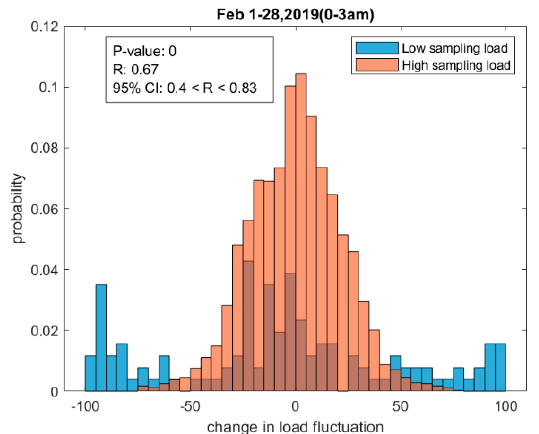
Figure 4. Load fluctuation distribution.